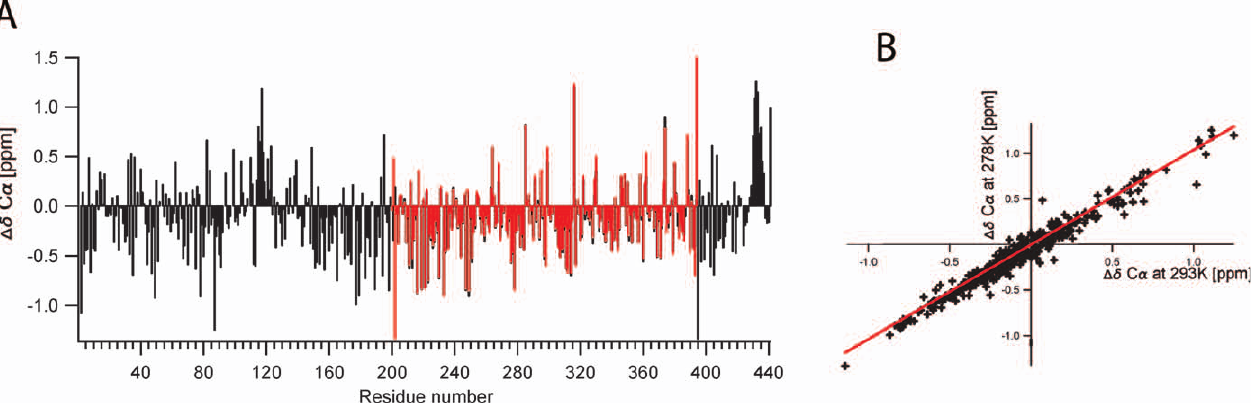
Figure 5. Robustness of Secondary Structure Propensity of Tau (A) Superposition of C a secondary chemicals shifts observed in 441-residue Tau (black) and in a 198-reside fragment (K32) comprising only the repeat domain and its flanking regions (shown as red bars). (B) Correlation of C a secondary chemicals shifts observed in htau40 at 278K and 293K. doi:10.1371/journal.pbio.1000034.g005 PLoS Biology |